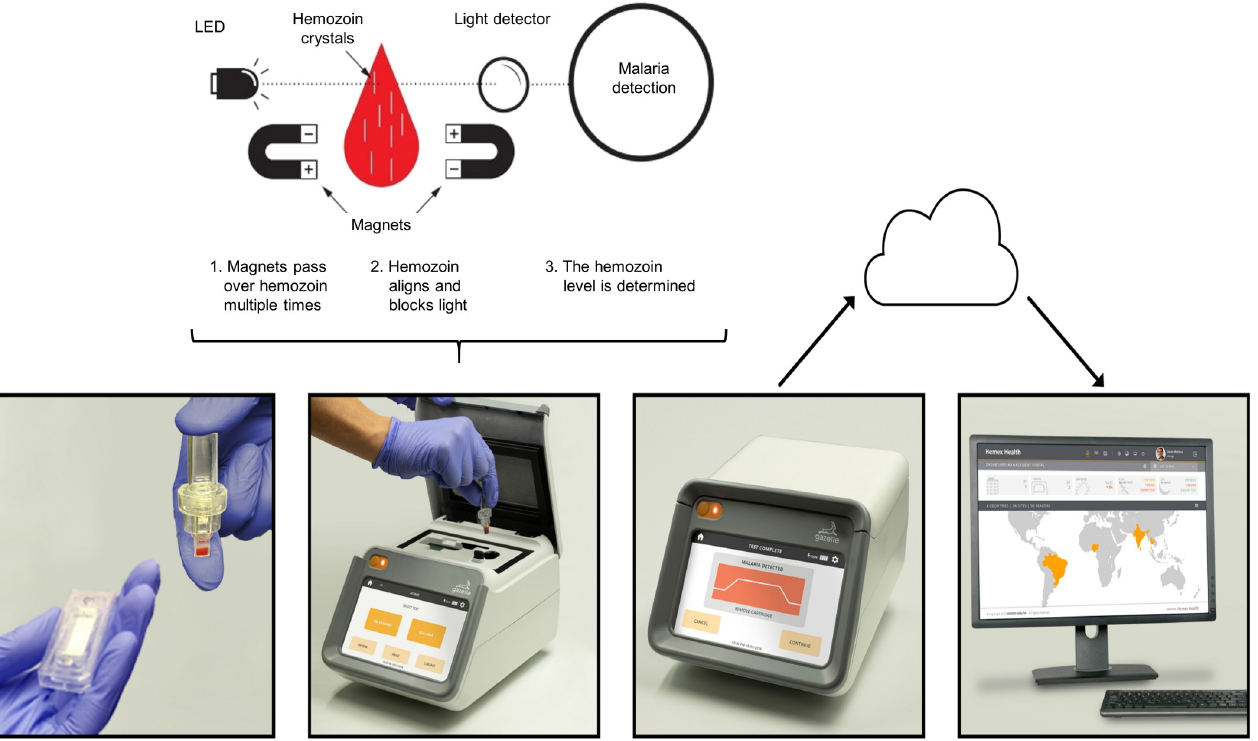
Fig 2. Gazelle device testing procedure. 15 μ L of whole blood are put on a cartridge with 80 μ L of whole blood Gazelle buffer. The sample is placed on the Gazelle device which lyse the sample by sonication and then pass magnets multiple times through the sample. Malaria detection is assessed by comparing the amount of light that traverse a sample with and without a magnetic